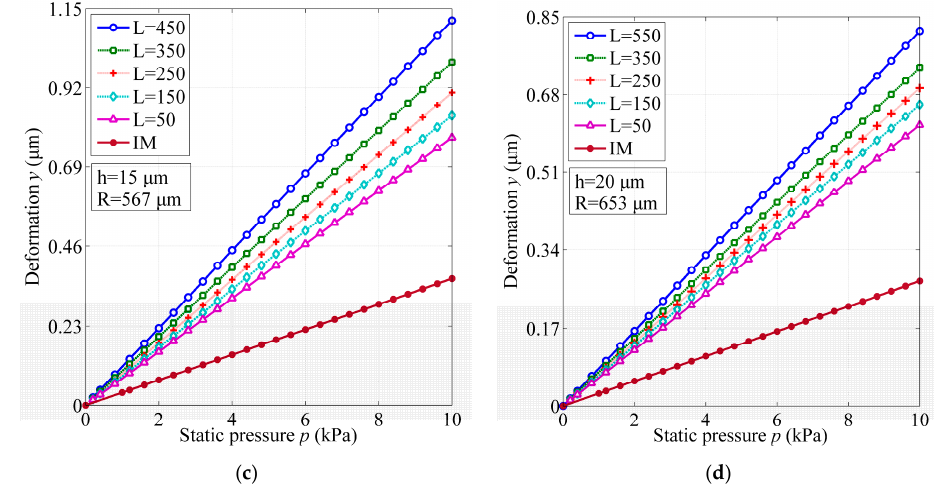
Figure 5. Linear responses of BSM structures and IM structures for different geometrical dimensions under typical acoustic pressures. ( a ) Membrane thickness h = 5 μ m and radius R = 327 μ m; ( b ) h = 10 μ m and R = 462 μ m; ( c ) h = 15 μ m and R = 567 μ m; ( d ) h = 20 μ m and R = 653 μ m.